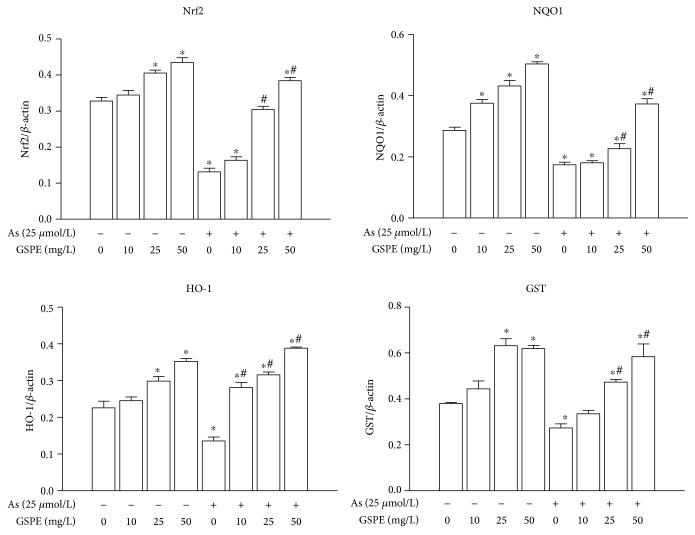
Quantitative protein analysis after treatment with arsenic and/or grape seed procyanidin extract. Nrf2, NQO1, HO-1, and GST protein expression levels were measured. Y-axis represents protein expression of test protein relative to β-actin. Each bar represents the mean ± SD. Significant differences relative to the control and arsenic groups are indicated as follows: ∗Versus the control group, P < 0.05; #versus the arsenic group, P < 0.05.